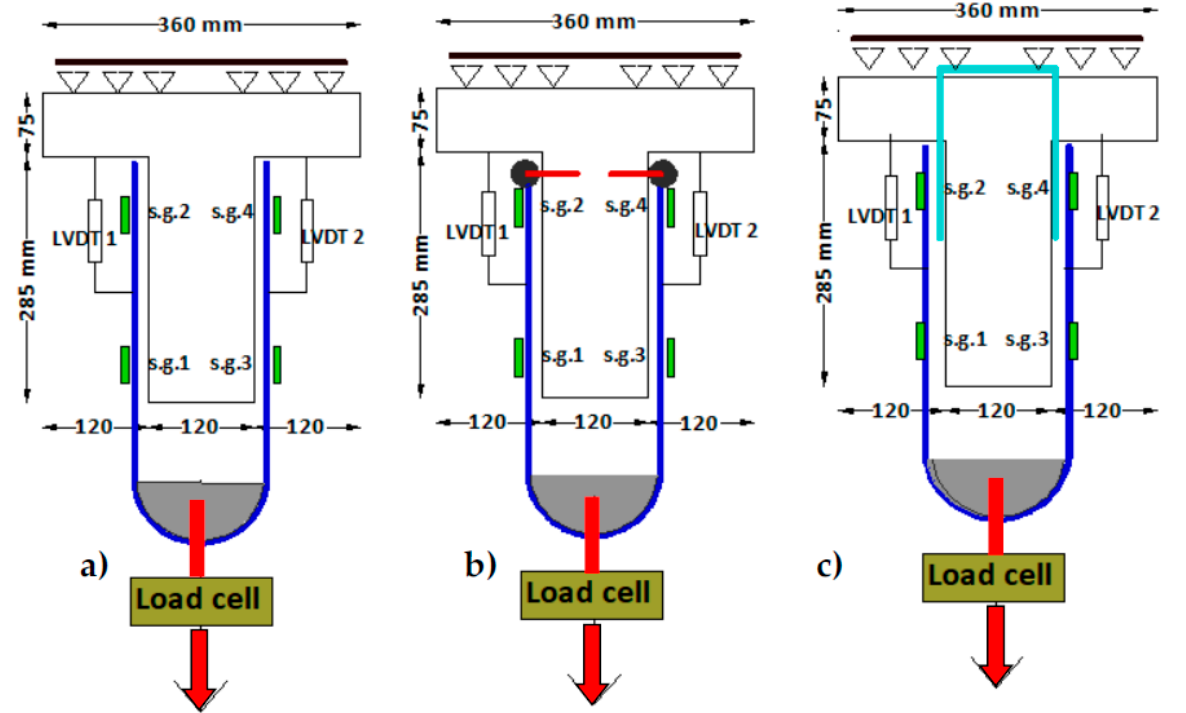
Figure 9. Testing three different open hoop CFRP strips employing a “unit T-beam” loading arrangement. ( a ) R/C “unit T-beam” with an open hoop FRP strip simply attached. ( b ) R/C “unit T-beam” with an open hoop FRP strip anchored with a mechanical anchor. ( c ) R/C “unit T-beam” with an open hoop FRP strip anchored with a rope FRP anchor. The following limit states were expected to occur during the “unit T-beam” loading.